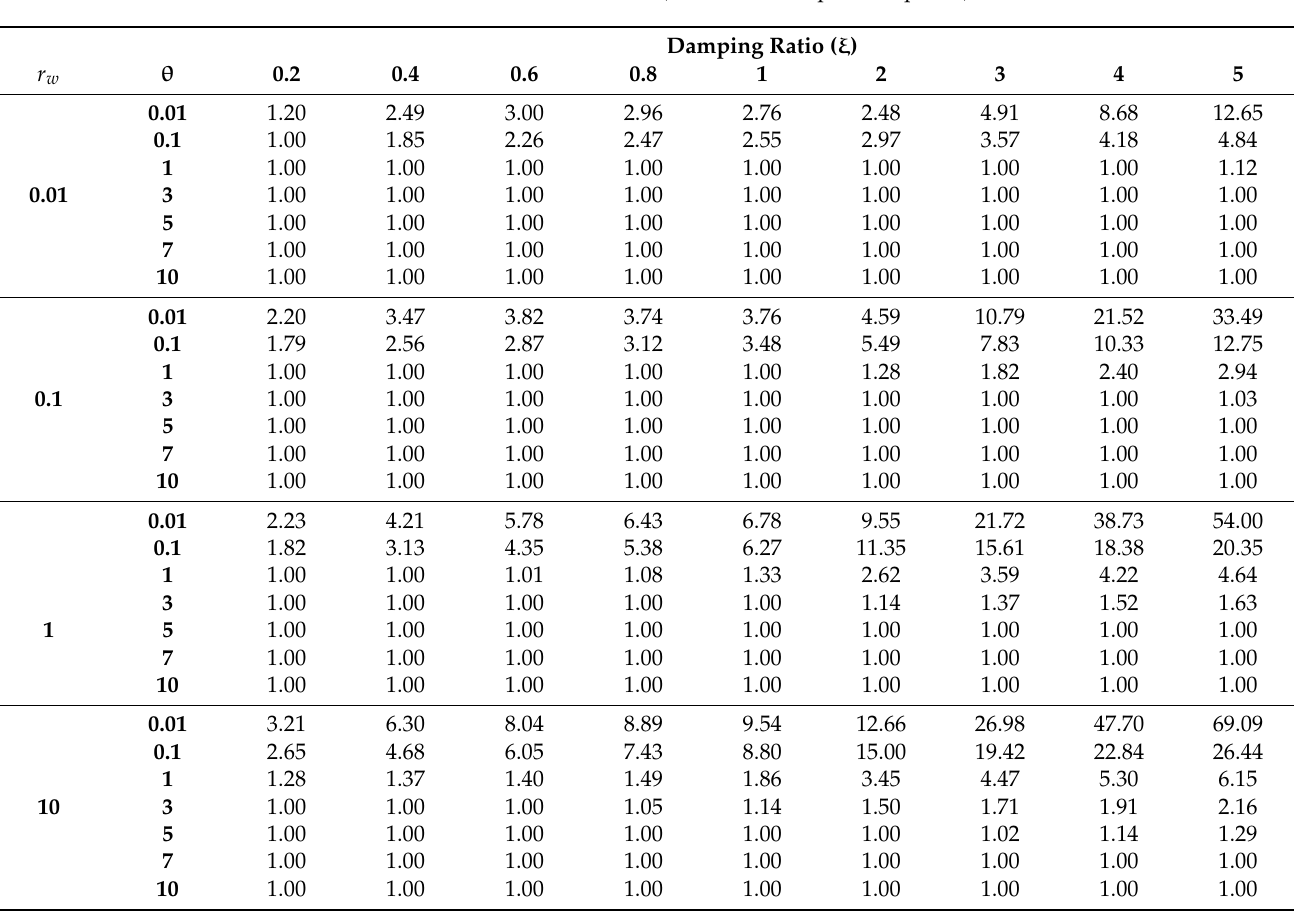
Table 2. Normalized IAE for MPC (Processes 1, setpoint response). Damping Ratio ( ξ